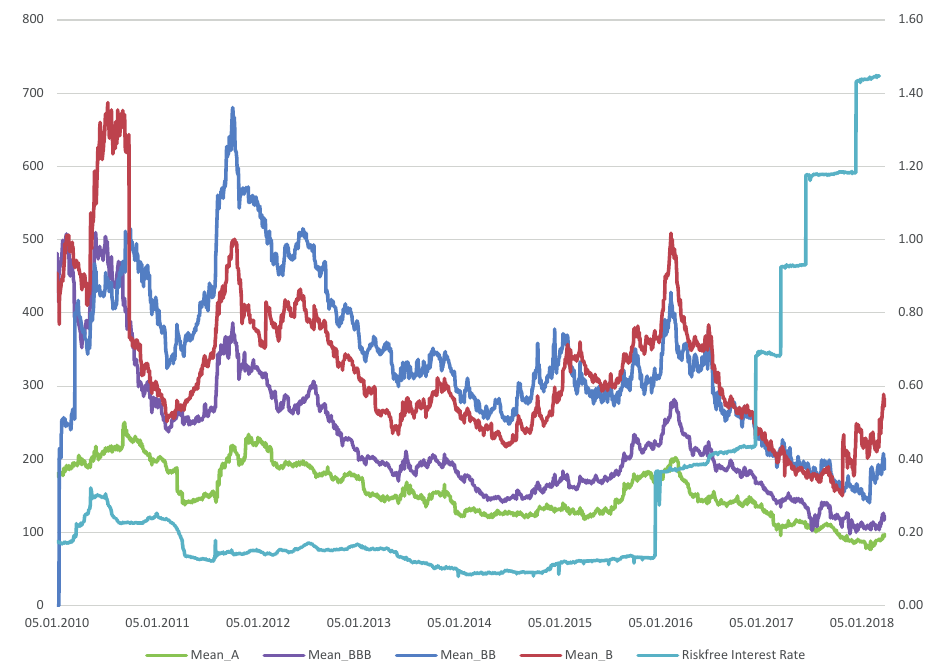
Figure 1. Bond spreads of credit rating categories over time (non-durables). The figure denotes the mean of A, BBB, BB, and B Spreads (category consumer non-durables; left-hand scale) and the risk-free interest rate (right-hand scale). Source: Authors,